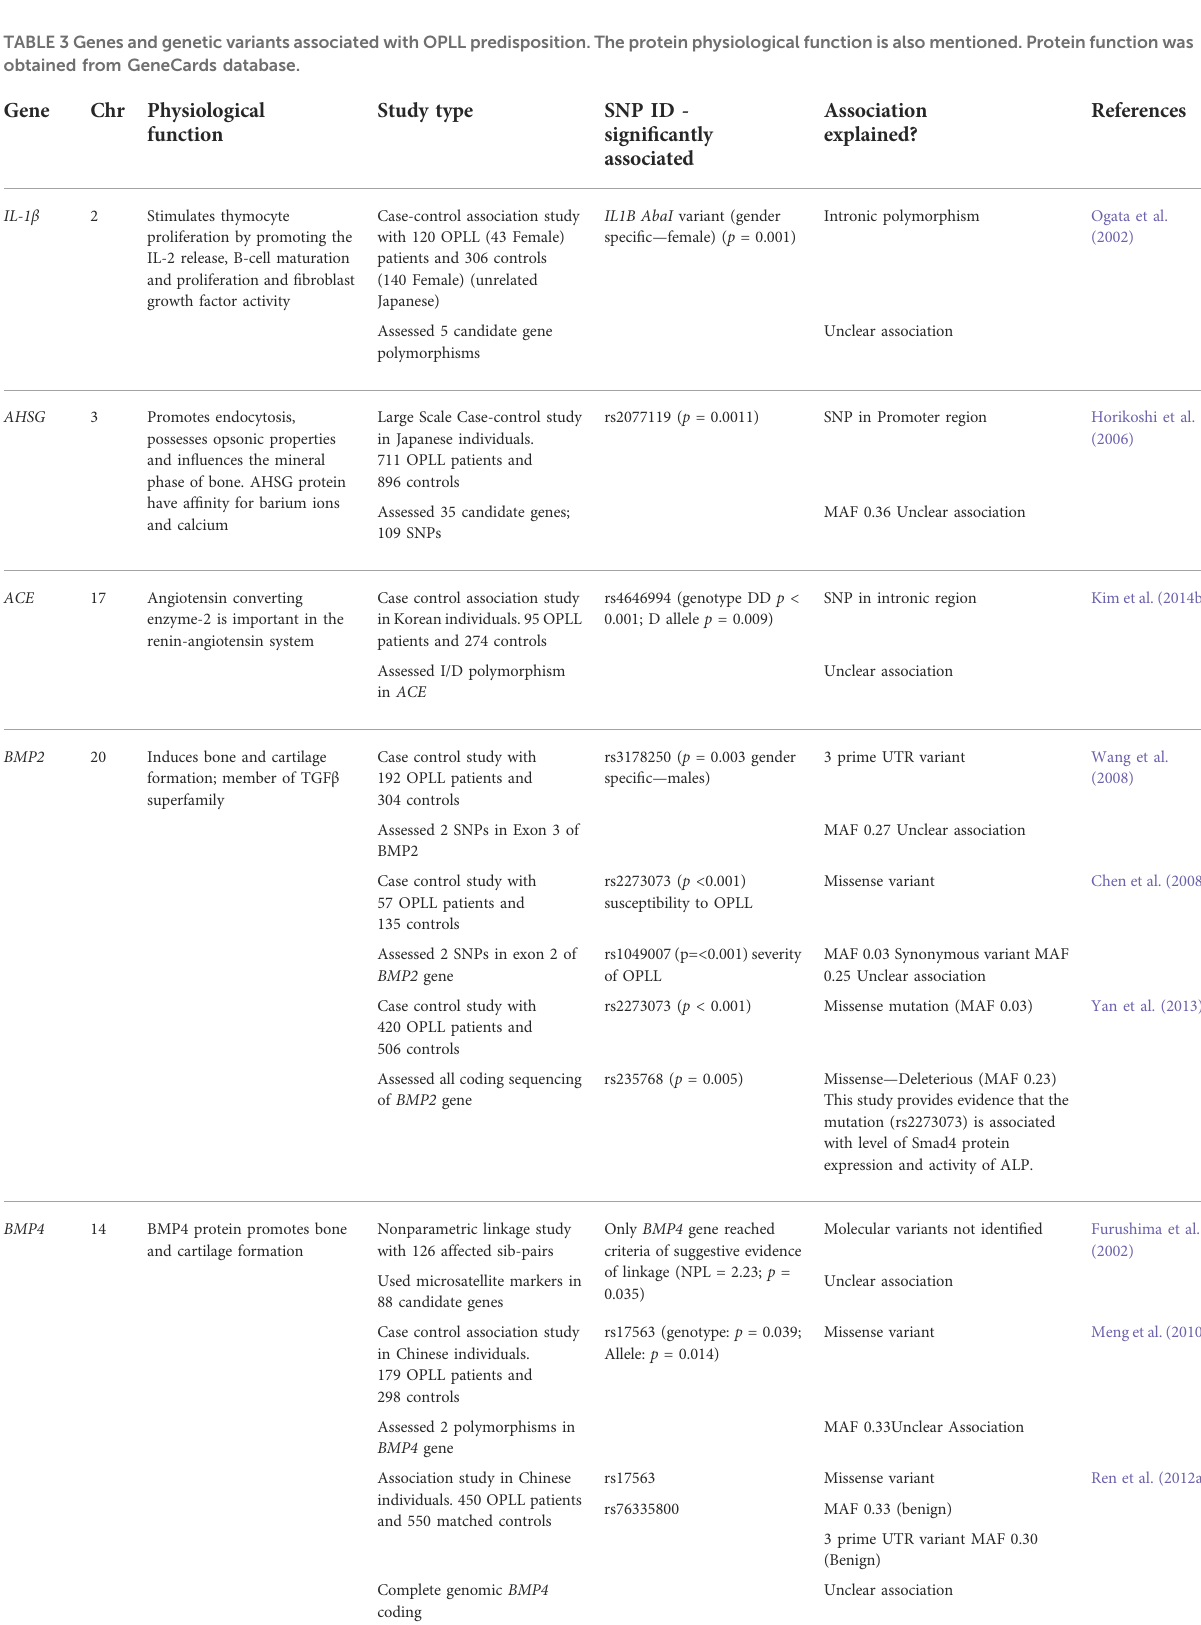
TABLE 3 Genes and genetic variants associated with OPLL predisposition.The protein physiological function is also mentioned.Protein function was obtained from GeneCards